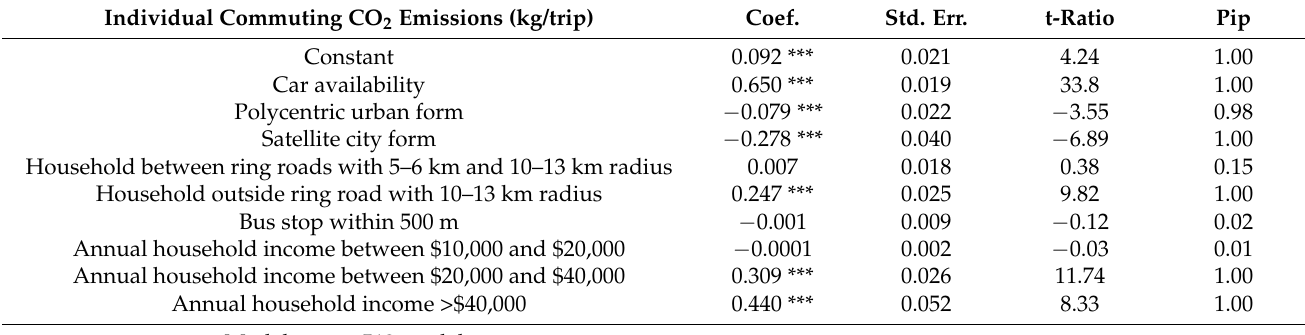
Table 3. Bayesian Model Averaging results in the three developing case cities